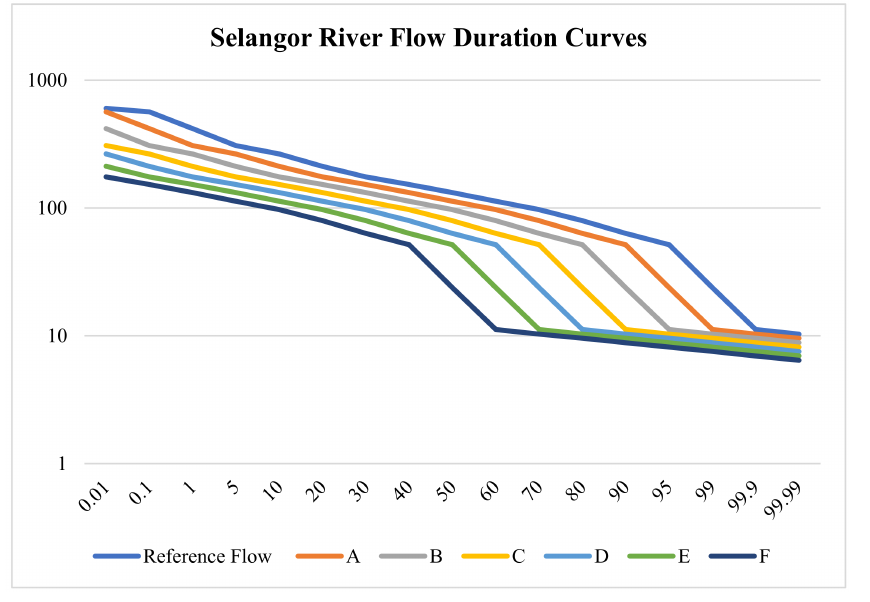
Figure 4. GEFC analyzed FDCs under different EMCs.